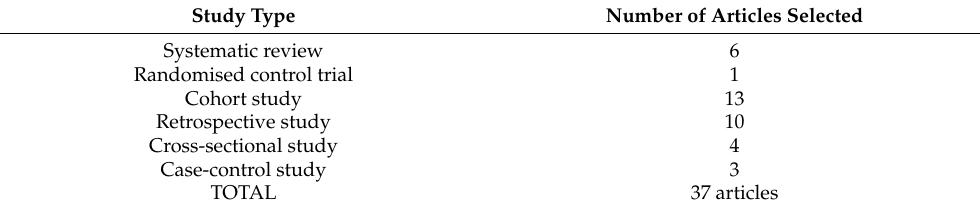
Table 2. Type of studies included in the systematic